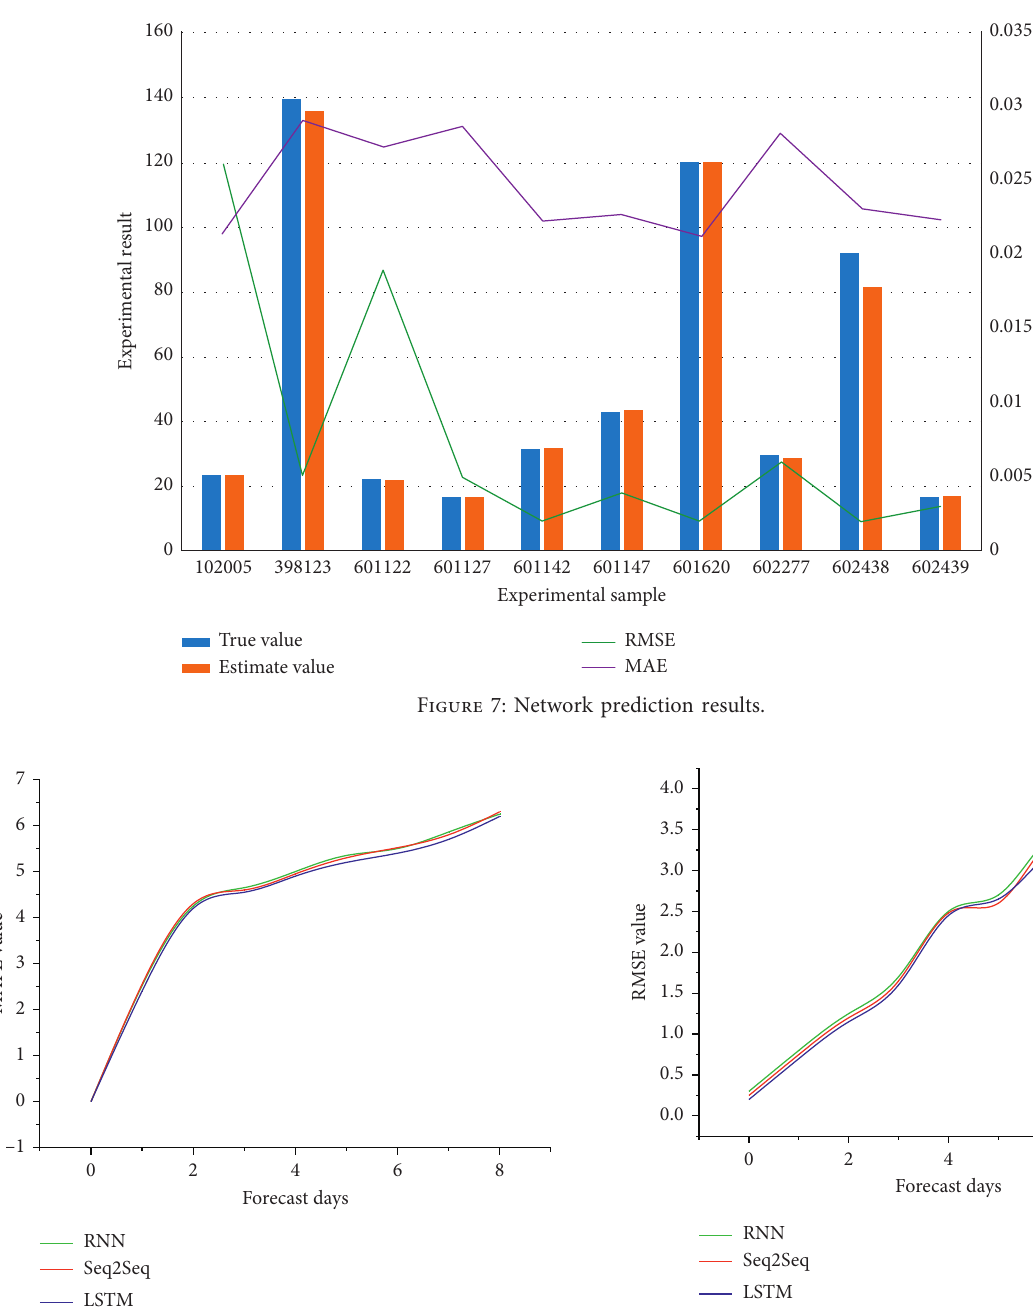
Figure 8: MAPE evaluation index. Figure 9: RMSE evaluation